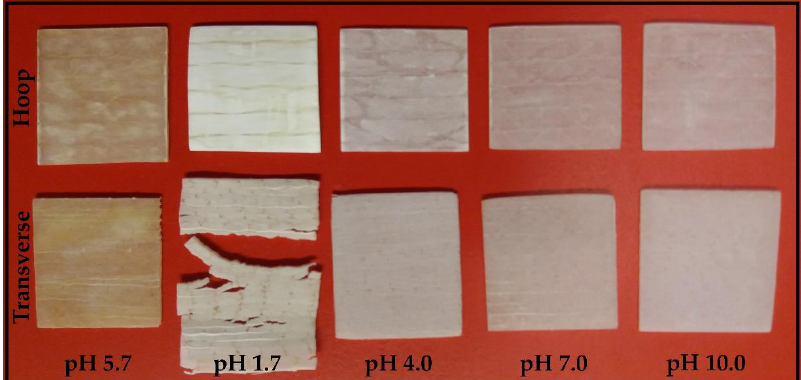
Figure 3. Effect of various pH levels of aqueous solutions on the degradation of R-glass GFRP plates with two fiber orientations (hoop and transverse orientations) after about a week (pH 1.7, 4.0, 7.0, and 10.0) and after four months (pH 5.7) of exposure.